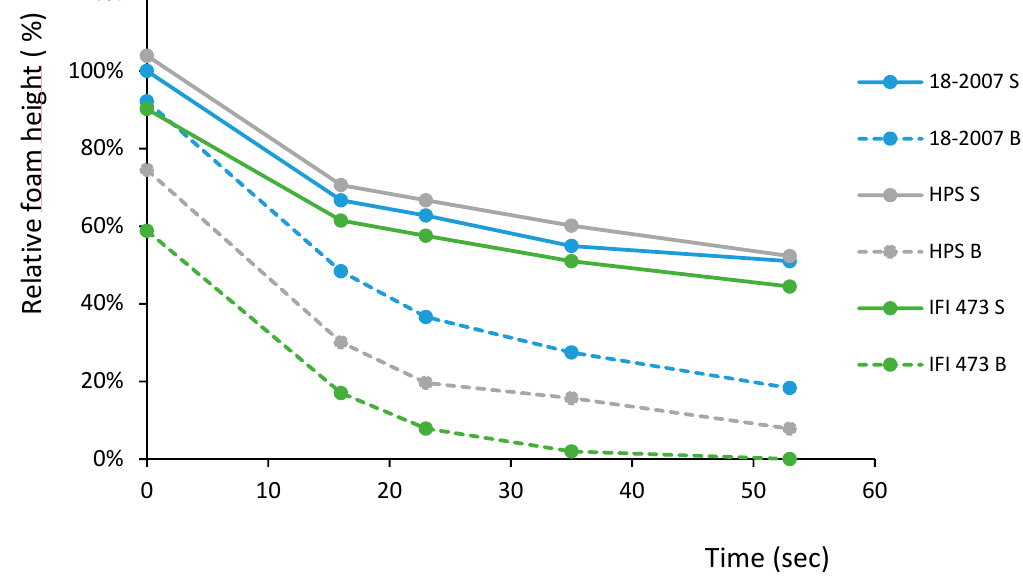
Figure 7. Kinetics of the six wine foam heights with time. S: sound (healthy) wines; B: Botrytized wines. All of the values were calculated through a comparison with the foam height of the sound wine obtained with the 18-2007 strain (18-2007-S = 100% when the liquid and the foam were visually separated after shaking).